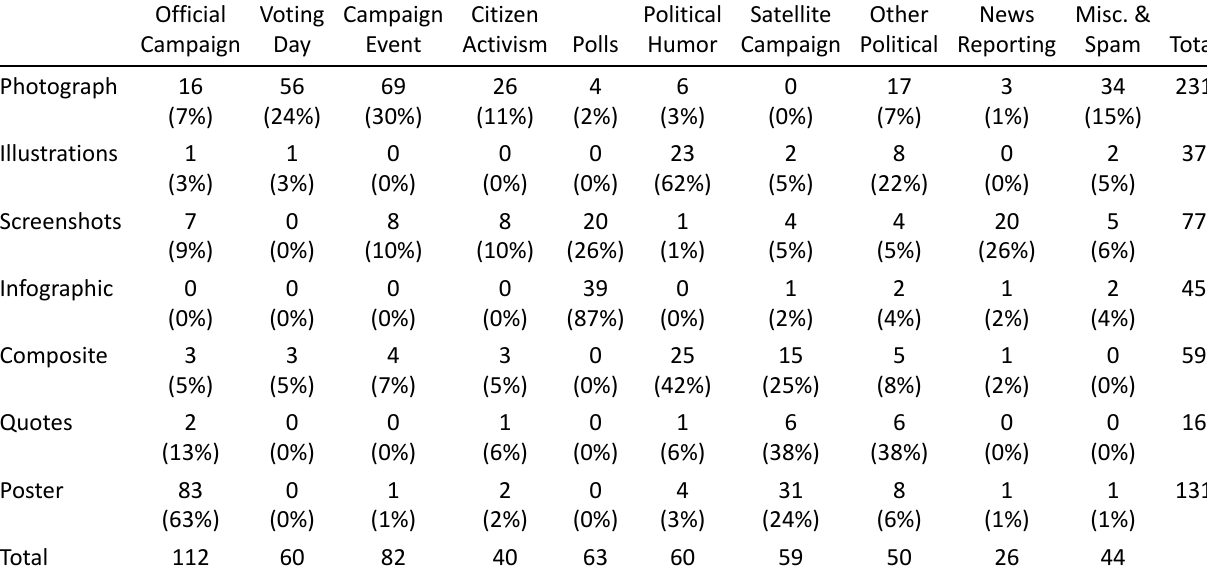
Table 3. Cross tabulations of visual and modal categories in ‘General’ sample (N, %). Official